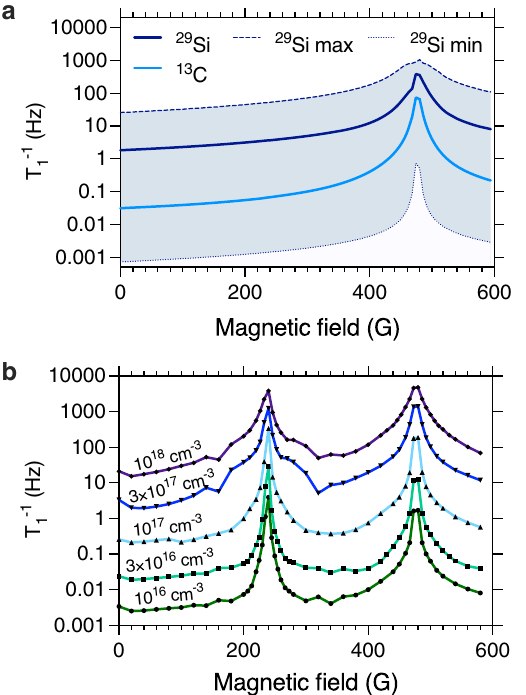
Fig. 8 Magnetic fi eld dependence of the longitudinal spin relaxation rate T (cid:1) 1 due to the nuclear spin of natural abundance 1 and spin-1/2 point defects. a Relaxation due to 29 Si (solid dark blue line) and 13 C (solid light blue line) nuclear spins are considered separately. When 13 C spin bath is considered the nearest-neighbor sites are excluded. For 29 Si we also depict the largest (dashed dark blue line) and the smallest (dotted dark blue line) relaxation rate found in our ensemble of 100 con fi gurations. The shaded area between these curves covers more than four orders of magnitude. b Magnetic fi eld dependence of the longitudinal spin relaxation rate due to spin-1/2 point defects of various concentrations.